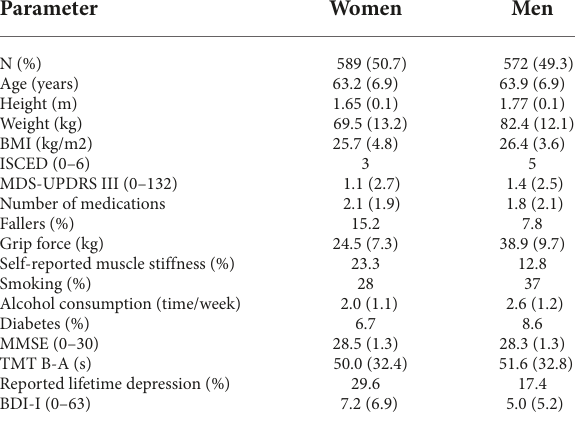
TABLE 2 Demographic and clinical data. Parameter